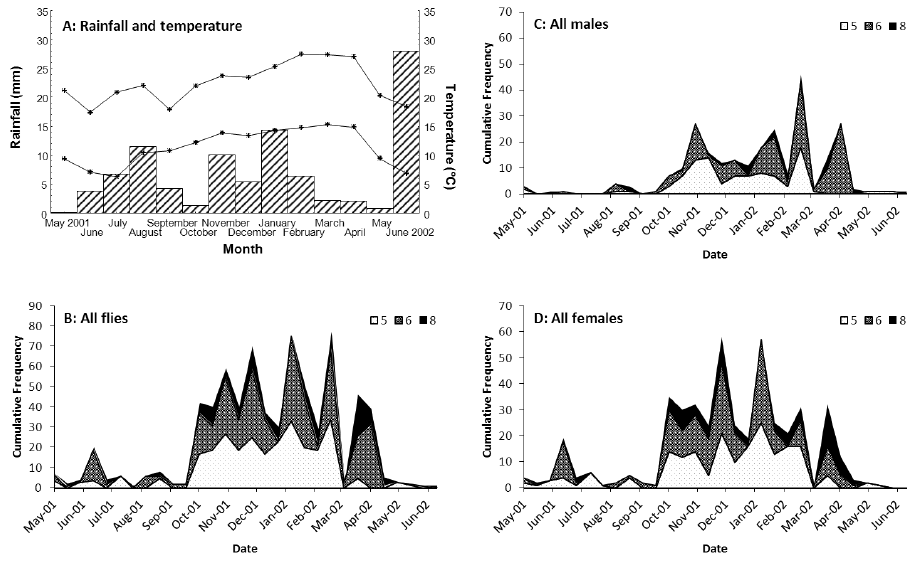
Figure 1. A Average rainfall histogram and mean minimum and maximum temperatures during the study period B–D : Captures of B all specimens C all male specimens and D all females of all species of flesh fly at carrion-baited traps in Grahamstown. The frequencies at each date are composed of subtotals from the three sites (Sites 5, 6, and 8) described in Table Table 2. Occurrence of males of flesh fly rarely collected at carrion-baited traps in Grahamstown. The three capture sites are described in Table 1.